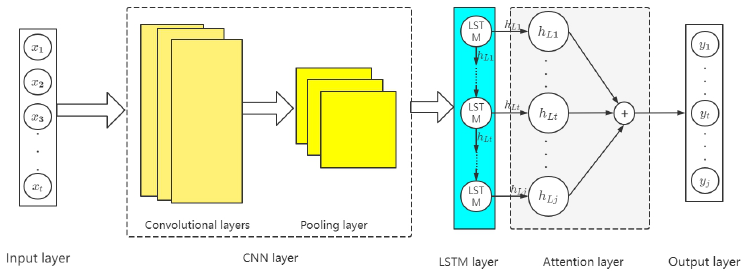
Figure 10. Attention CNN-LSTM model structure